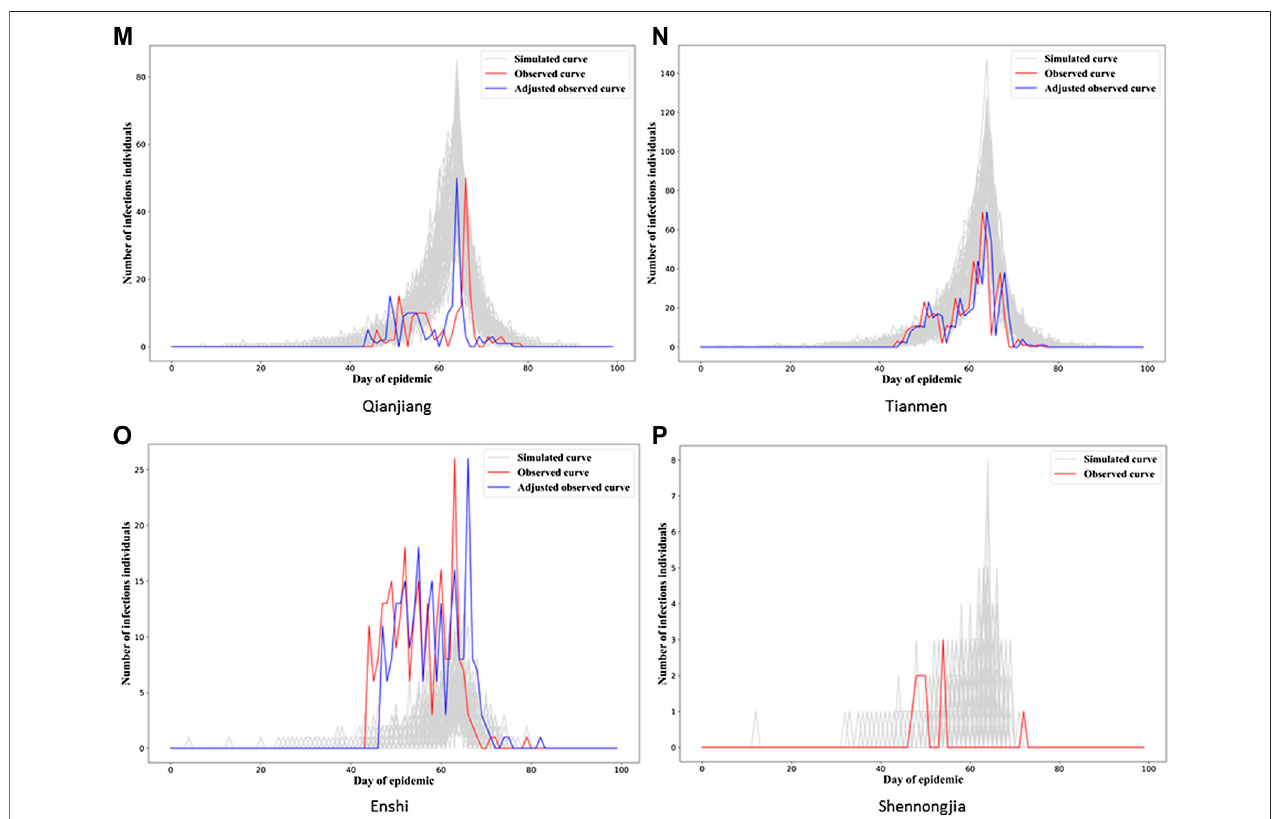
FIGURE 6 | Observed and simulated epidemic curves under fi nal model for four cities in Hubei (for Wuhan, see Figure 3 ). Real data shown in red; shifted real data accountingforpotentialdifferencesindelaystoreportingindifferentcitiesshowninblue;darkgraycurvesrepresent70%ofcurvessimulatedfromthe fi nalmodelclosest to the true